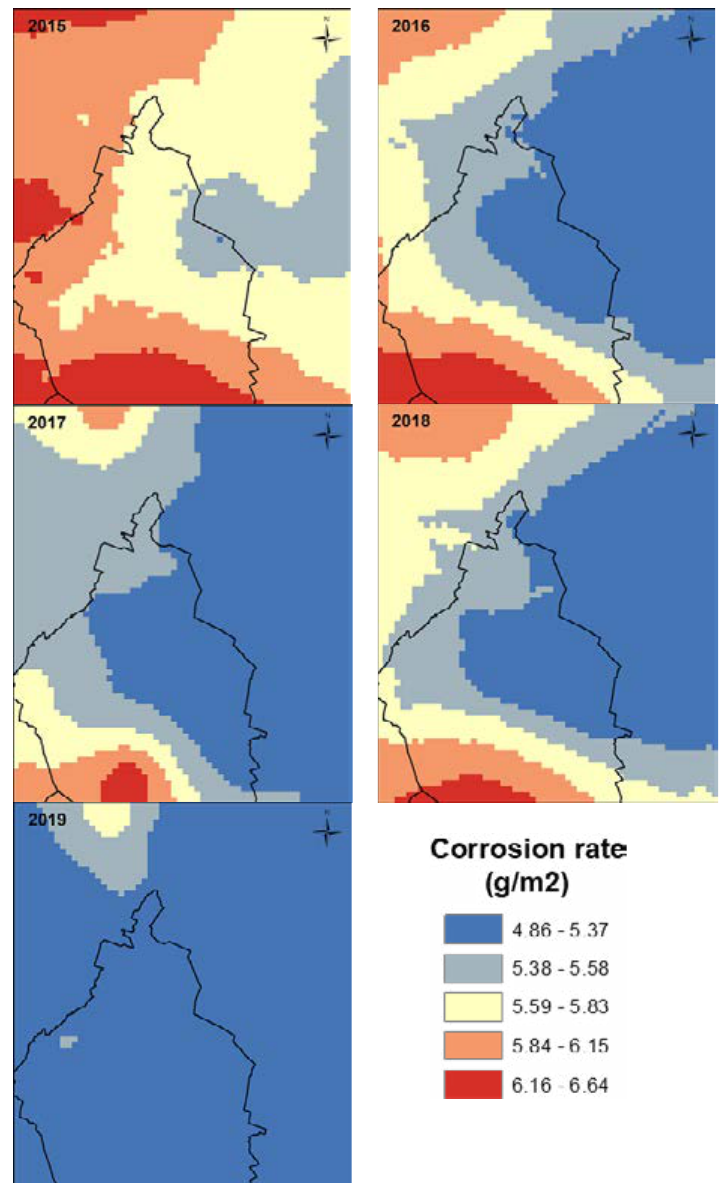
Fig. 5: Corrosion rate maps (g/m 2 ) of zinc, for a multi-pollutant situation without the HNO 3 component for the period 2015-2019 in the MCMA